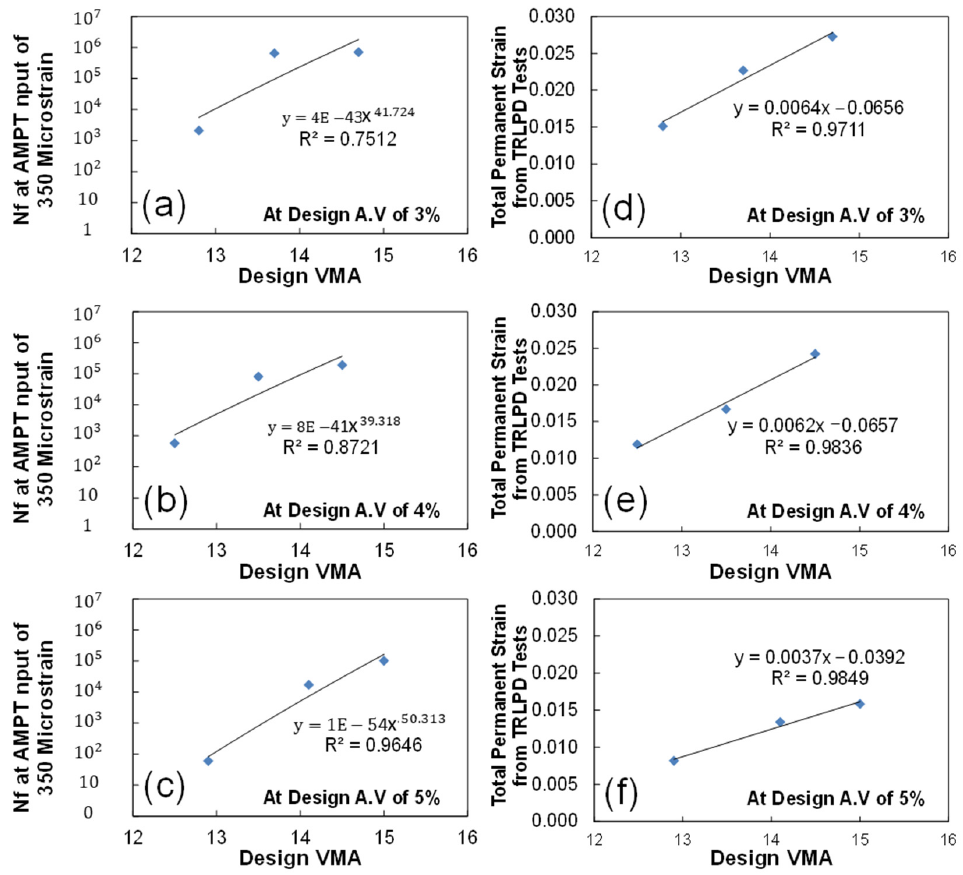
Figure 16. Development of the mathematical models on the relationship between the performance index and predicted performance (AMPT ( a – c ); TRLPD ( d – f )) at design air voids of 3% ( a , d ), 4% ( b , e ), and 5% ( c , f ).